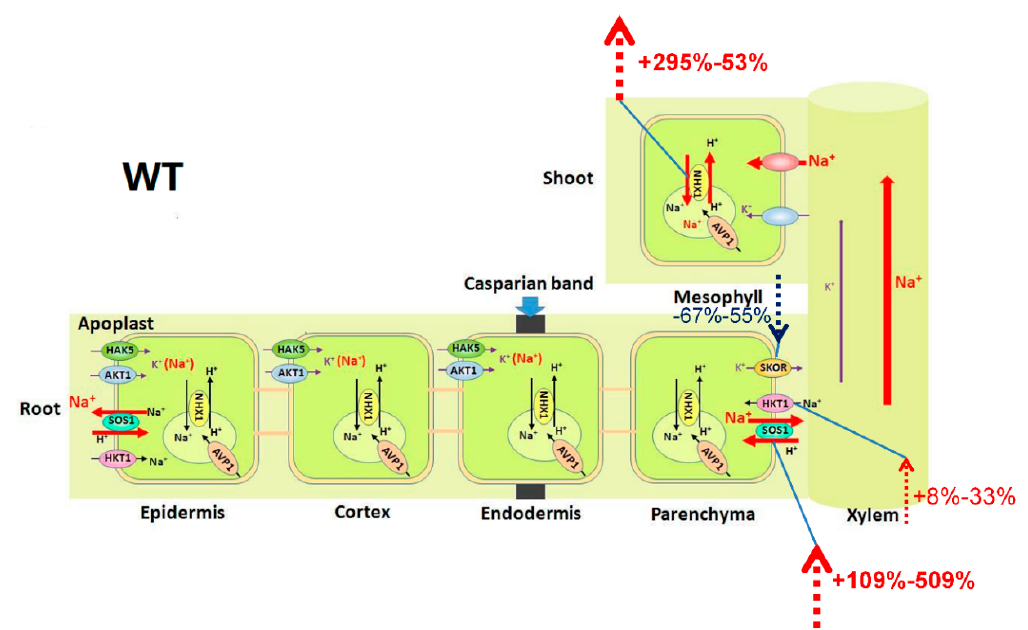
Figure 5. Schematic model for the function of AtHKT1;1 and AtSOS1 in regulating K + and Na + transport in WT of Arabidopsis thaliana ( A. thaliana ) under saline conditions. For the plants growing in 25 mM NaCl, the expression level of AtNHX1 increased 295% at 6 h and 53% at 24 h, indicating that AtNHX1 could efficiently compartmentalize Na + into the vacuoles of the shoots. The addition of 25 mM NaCl induced a 109–509% (6–24 h) increase in transcripts of AtSOS1 but only an 8–33% (6–24 h) increase in transcripts of AtHKT1;1 in the roots. At the same time, 25 mM NaCl induced a 67–55% (6–24 h) decrease in transcripts of AtSKOR in the roots. Consequently, Na + was loaded into the xylem and delivered to the shoots, whereas K + was